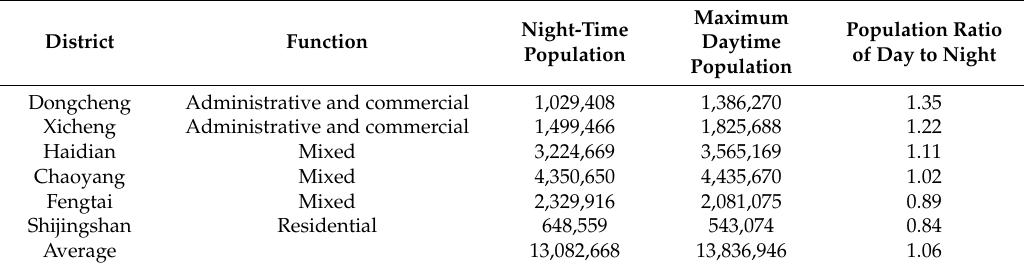
Table 2. Population ratios of day to night in the six central districts of Beijing.